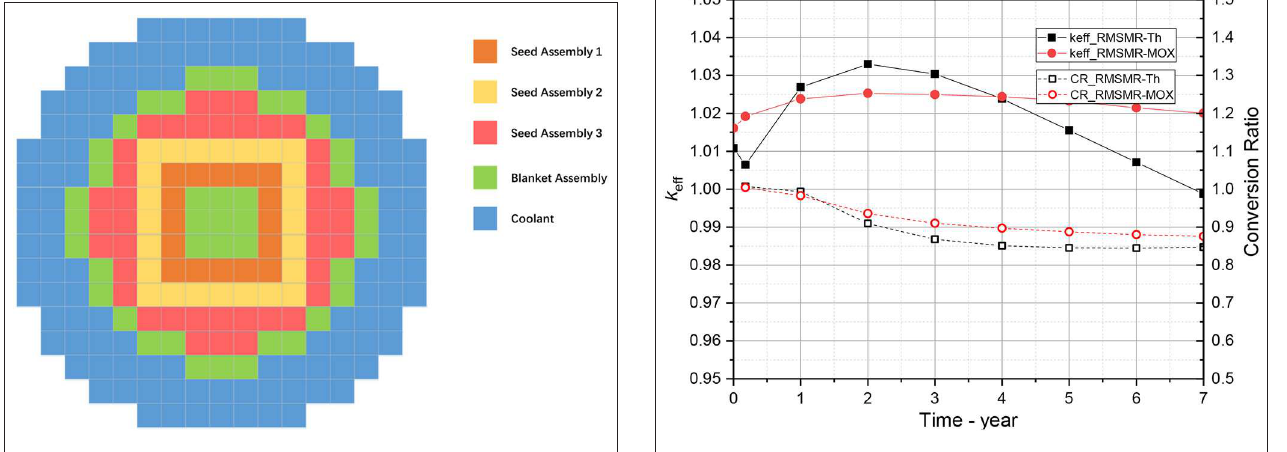
FIGURE 2 | Radial schematic view of RMSMR-Th.